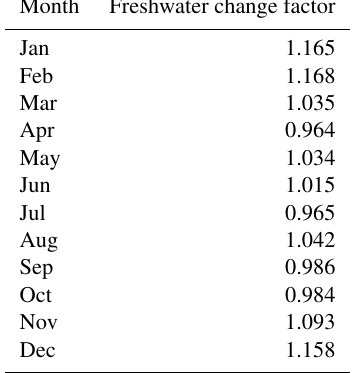
Table 2. Monthly freshwater discharge fractional change factor used for the TMDL + riverCC, TMDL + allCC, and Base + allCC scenarios, calculated as the ratio between the freshwater inputs in 2050 divided by the freshwater inputs in the Base